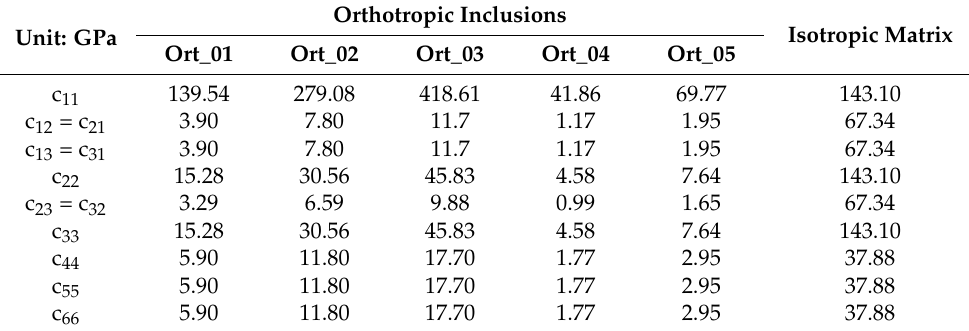
Table 3. Material Properties of the Isotropic Matrix and the Orthotropic Inclusions.